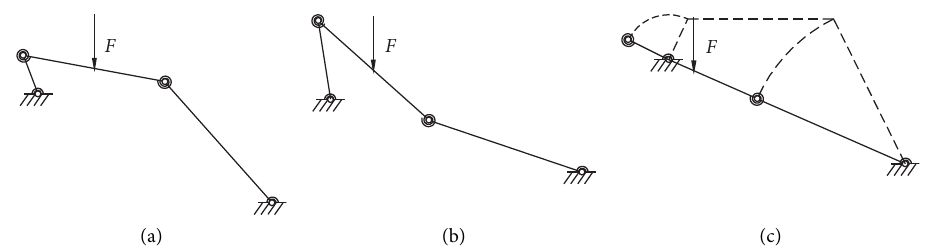
Figure 13: Typical deformed shape of an asymmetric frame when (a) h